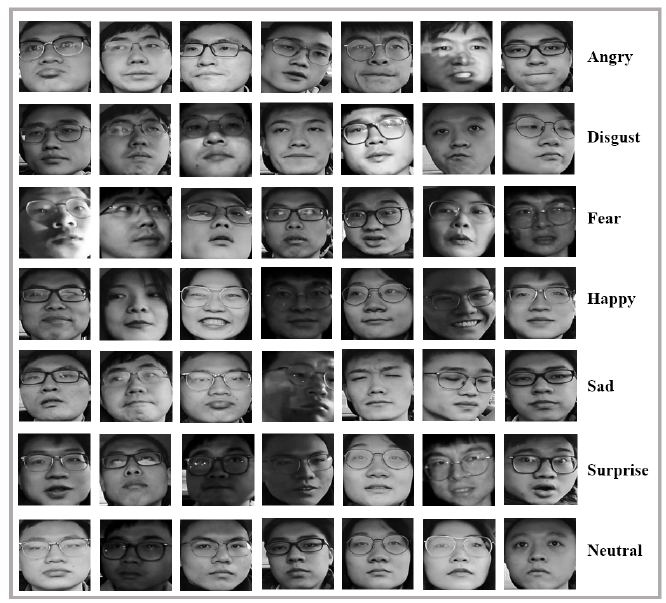
Figure 5. Driver facial expressions in gray images processed by the FD module.